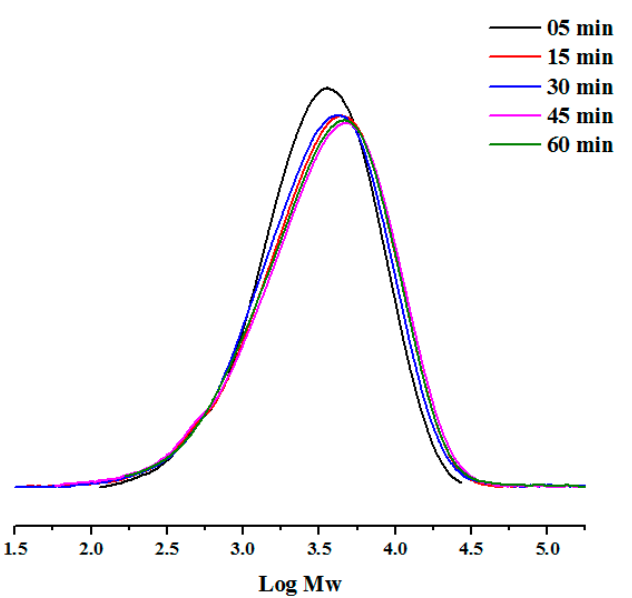
Figure 6. GPC curves of the PE produced using Ni1 /EtAlCl 2 at different reaction times (runs 4, 10–13, Table